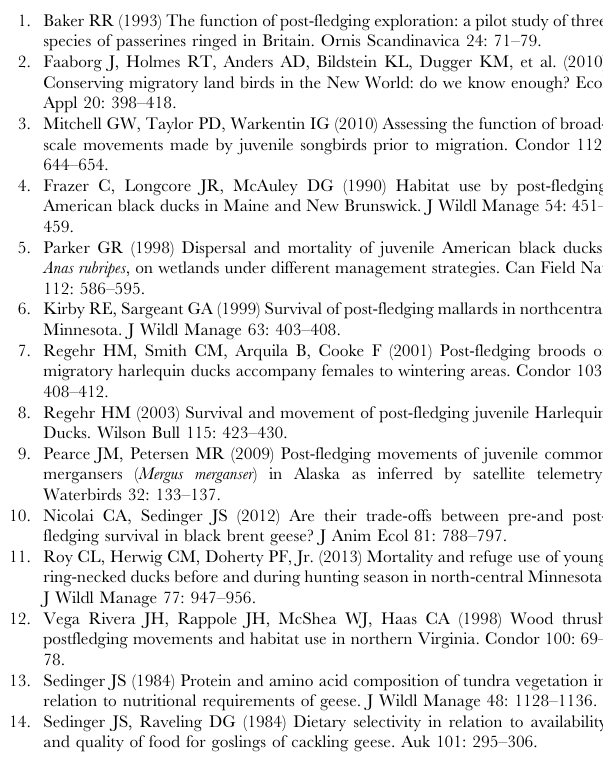
using QIC). The gray vertical line (and hatched fill) demarcates the hunting season. Figure S3 Distribution of weekly observations among potential disturbance categories (low, high) and refuge indicators (yes, no). Data are pooled across 2007–2010. The width of each bar reflects the sample size associated with the weekly observation interval, whereas the height reflects the relative distribution of observations within each of these intervals. These data illustrate that: a) refuges are used more frequently over time, beginning in week 7 or 8; b) non-refuge, low disturbance lakes are also used more frequently over time; and c) the latter category comprises the majority of observations in the low potential for disturbance category until week 12 or 13. Figure S4 (a) Weekly fall net displacements in the Eastern (left panel) and Southern (right panel) directions averaged across ring- necked ducks. Data were collected in north-central Minnesota and pooled across 2007–2010. Net displacements represent differences in UTM coordinates between a bird’s current location, ( X t , Y t ), and the centroid of a bird’s natal lake ( X 0, Y 0 ). Specifically, the left panel depicts weekly among-bird means of: ( X t – X 0 ), and the right panel depicts weekly among-bird means of: 2 ( Y t – Y 0 ). S4b. Average weekly fall displacements in the Eastern (left panel) and Southern (right panel) directions by ring-necked ducks. Data are pooled from 2007–2010. Displacements represent differences in UTM coordinates between a bird’s current ( X t , Y t ) and previous locations ( X t 2 1, Y t 2 1 ) in north-central Minnesota. Specifically, the left panel depicts weekly among-bird means of: ( X t – X t 2 1 ) and the right panel depicts weekly among-bird means of: 2 ( Y t – Y t 2 1 ). On